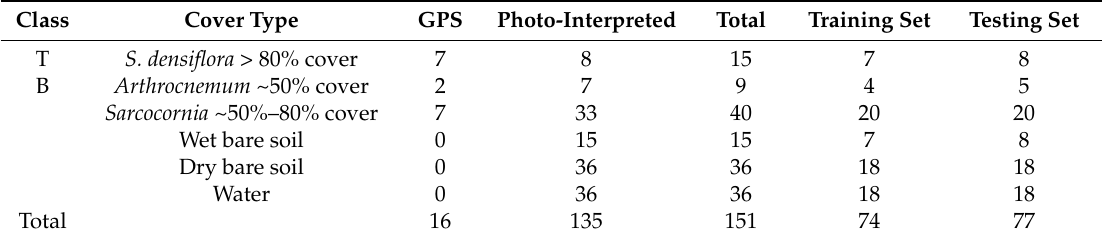
Table 3. Ground-truth polygons used for training the spectral detection algorithms (training set) and for validation (testing